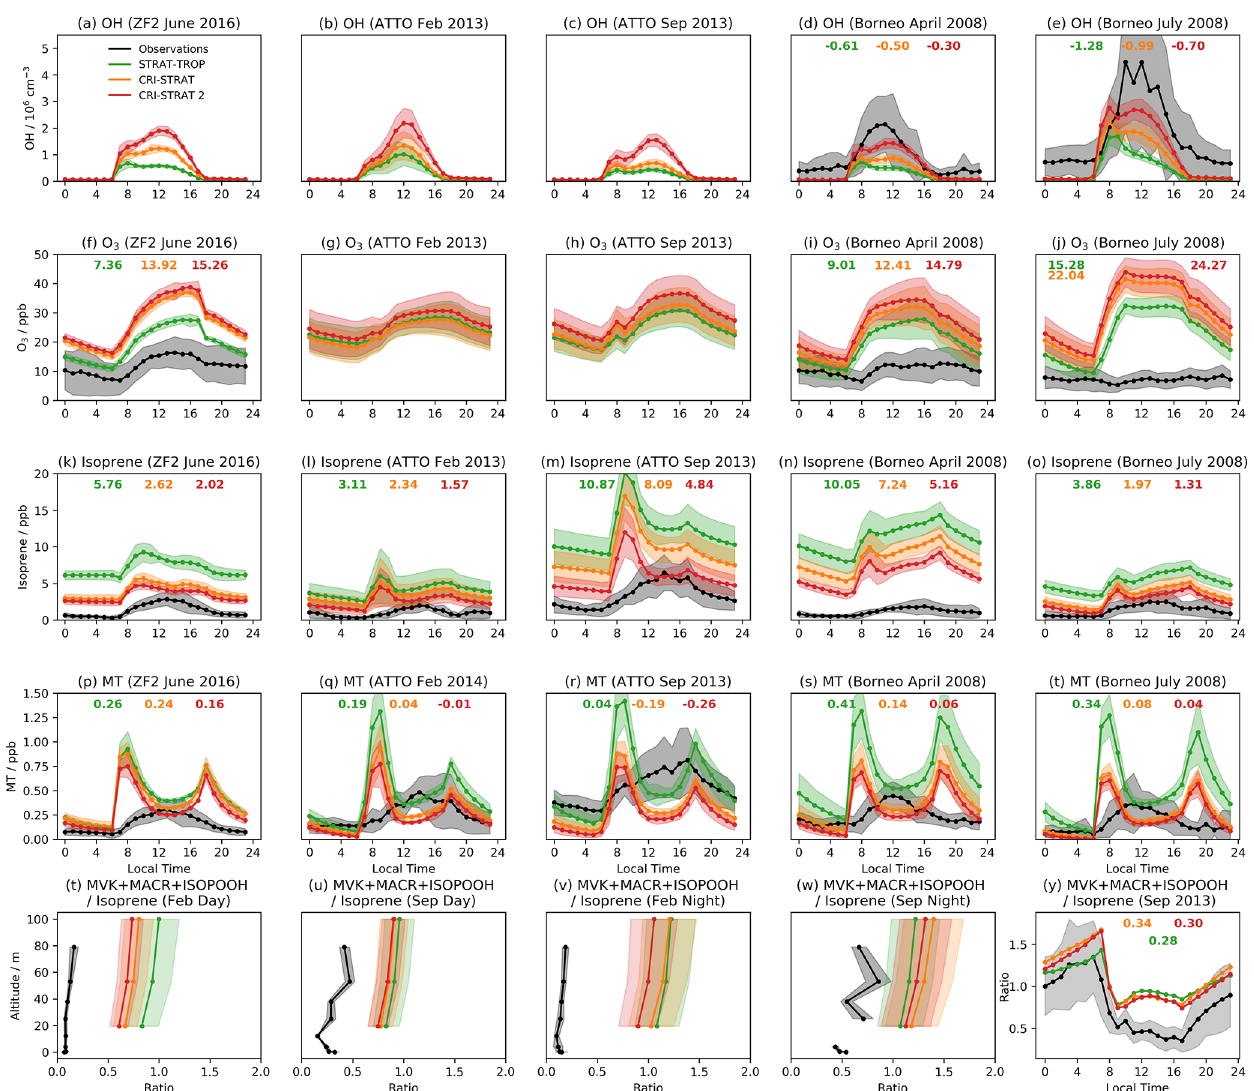
Figure 1. Mean diel cycles of observed and modelled OH (top row), O 3 (second row), isoprene (third row), and MT (MT = α -pinene + β -pinene for the CRI mechanisms) (fourth row) at the three surface and near-surface sites considered. The bottom row shows the vertical profile of the ratio of the isoprene oxidation products MVK + MACR + ISOPOOH to isoprene for daytime (09:00–15:00LT) and nighttime (21:00–03:00LT) periods and the diel profile of the ratio at 53m (all from ATTO tower). Shading indicates ± 1 standard deviation from the mean, and the numbers in bold show the mean diel model bias (model–observations) for species or locations where observations were